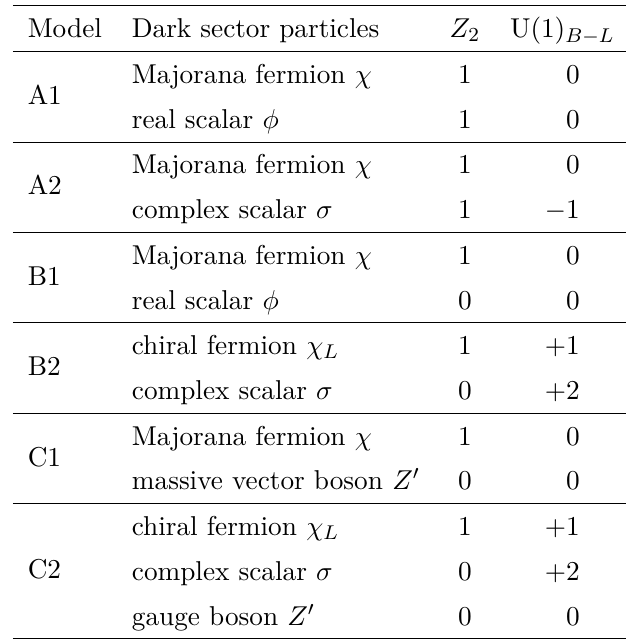
Table 2 . Dark sector particles in the UV-complete models together with their Z 2 and B − L charges. Under the Z symmetry, a field ϕ → e iπk ϕ , with k = 0 or 1 being the Z 2 addition to these particles and the SM ones, each model contains RH neutrinos N under Z and having B − L charge of − 1 . See text for further 2